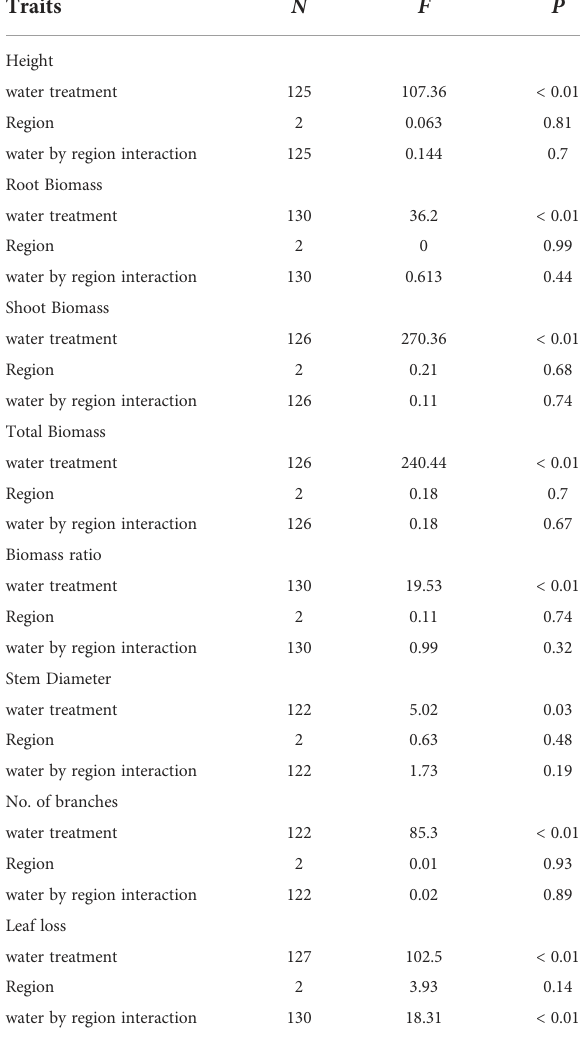
TABLE 4 Summary of Linear Mixed Effects regression model shows differences in drought response between regions with varying soil moisture contents, two contrasting water treatments and their interactions on 8 phenotypic traits in